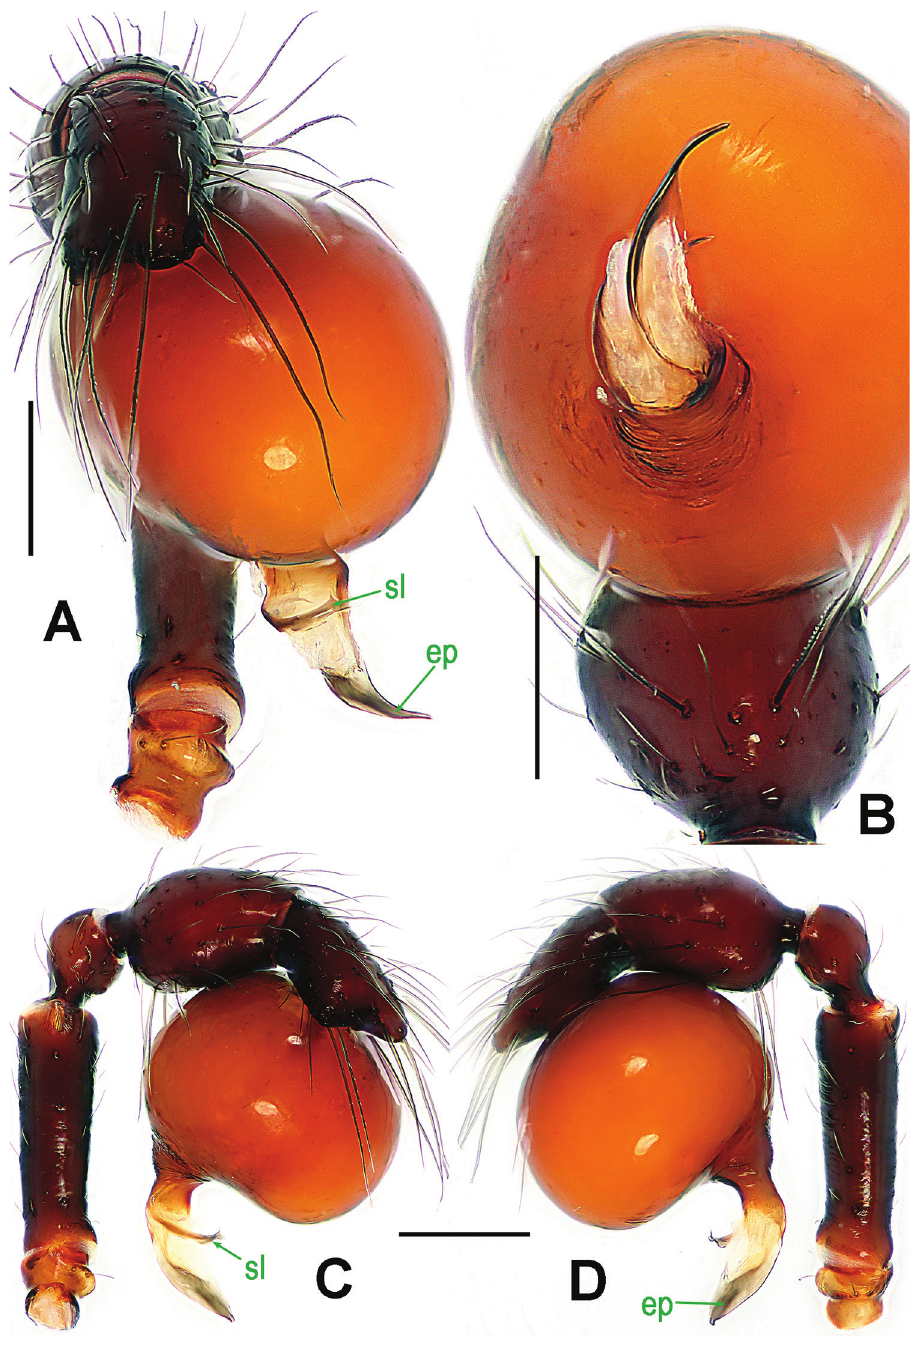
Figure 2. Paculla bukittimahensis sp. n., male holotype. A, C–D left palp B palpal bulb. A anterior B ventral C prolateral D retrolateral. Abbreviations: ep = embolic part of apes of palpal organ; sl = sub- terminal lamella. Scale bars: 0.20